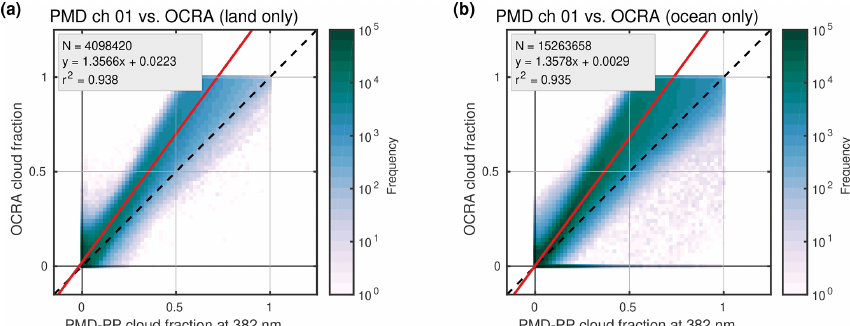
Figure 18. Comparison between MICRU PMD at 382nm and OCRA based on CF data from April 2010: measurements over (a) land and (b) ocean. This comparison applies cropped